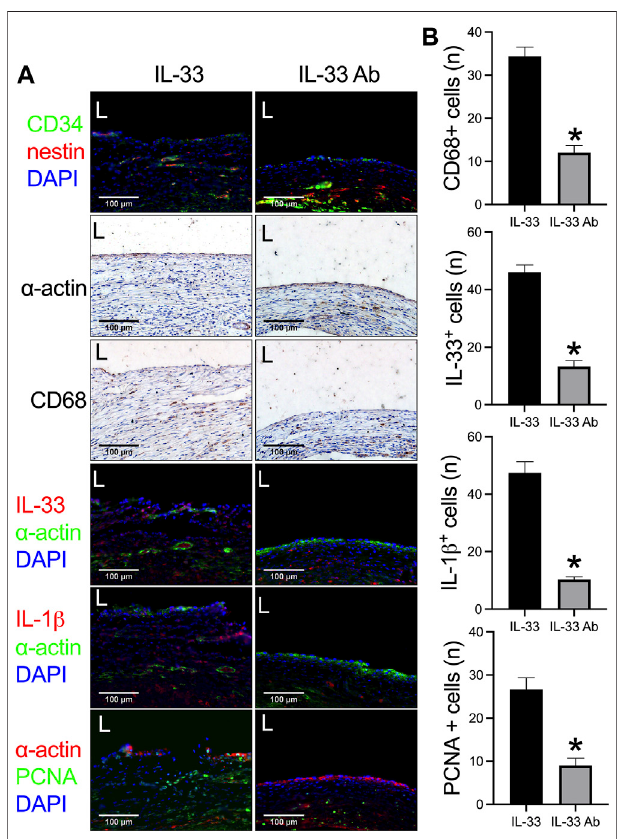
FIGURE 6 | IL-33 antibody (IL-33 Ab)-absorbed plant leaf can decrease IL-33 expression and neointimal hyperplasia in a rat inferior vena cava (IVC) venoplasty model. (A) First row, immuno fl uorescence stained for CD34 (red), nestin (green), and DAPI (blue) in the neointima; second and third rows, immunohistochemistrystainedfor α -actinandCD68intheneointima;fourthto sixth rows, immuno fl uorescence stained for IL-33 (red), α -actin (green), and DAPI (blue); IL-1 β (red), α -actin (green), and DAPI (blue); and PCNA (green), α -actin (red), and DAPI (blue) in the IL-33 and IL-33 Ab-absorbed plant patch; L, lumen; scale bar 100 μ m; n (cid:2) 3. (B) Bar graphs showing the CD68 positive cells (*, p (cid:2) 0.0013, t-test), IL-33 positive cells (*, p (cid:2) 0.0006, t-test), IL-1 β positivecells(*, p (cid:2) 0.0008,t-test), andPCNApositivecellsintheneointima (*, p (cid:2) 0.0054, t-test); n (cid:2)